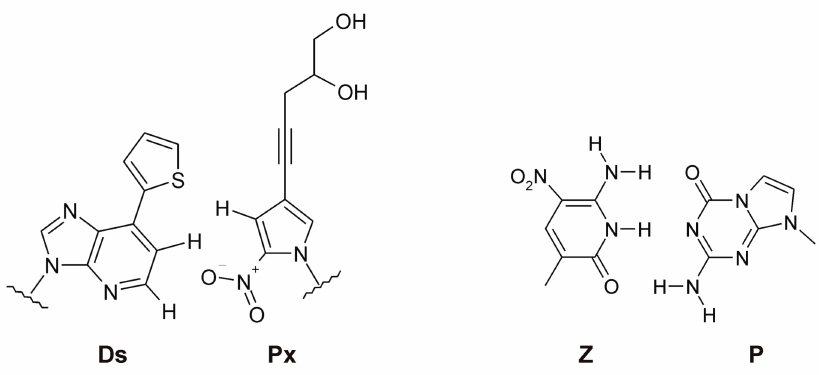
Figure 5. Chemical structures of artificial base pairs Ds:Px [95] and Z:P